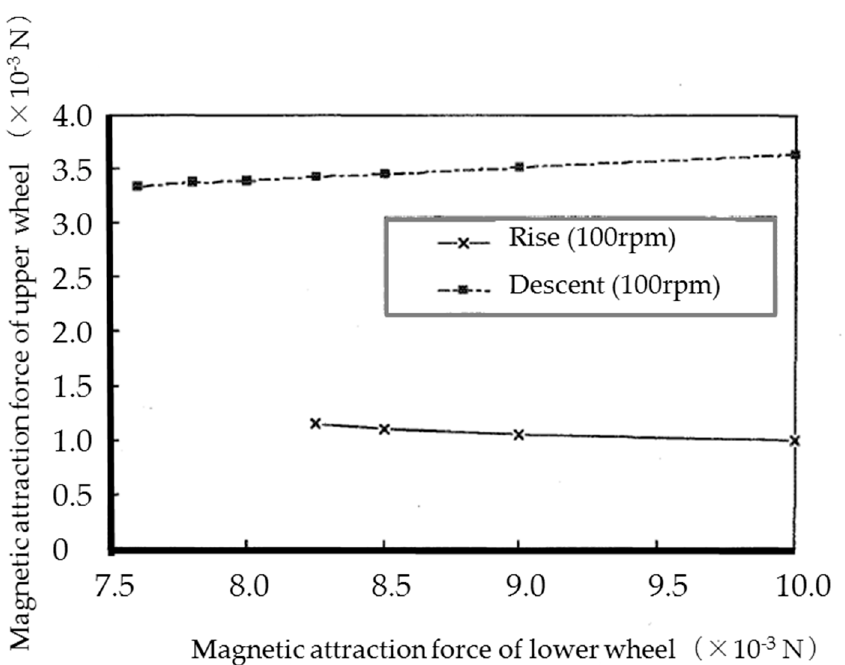
Figure 9. The relationship between the magnetic attraction force of the upper and lower wheels of a single microrobot capable of vertical movement up and down. We observed that a larger magnetic attraction force is required for the upper wheels when descending than when climbing. It is better if the magnetic attraction force of the lower wheels is larger and the magnetic attraction force of the upper wheel is smaller when climbing, and the opposite is true for descending.